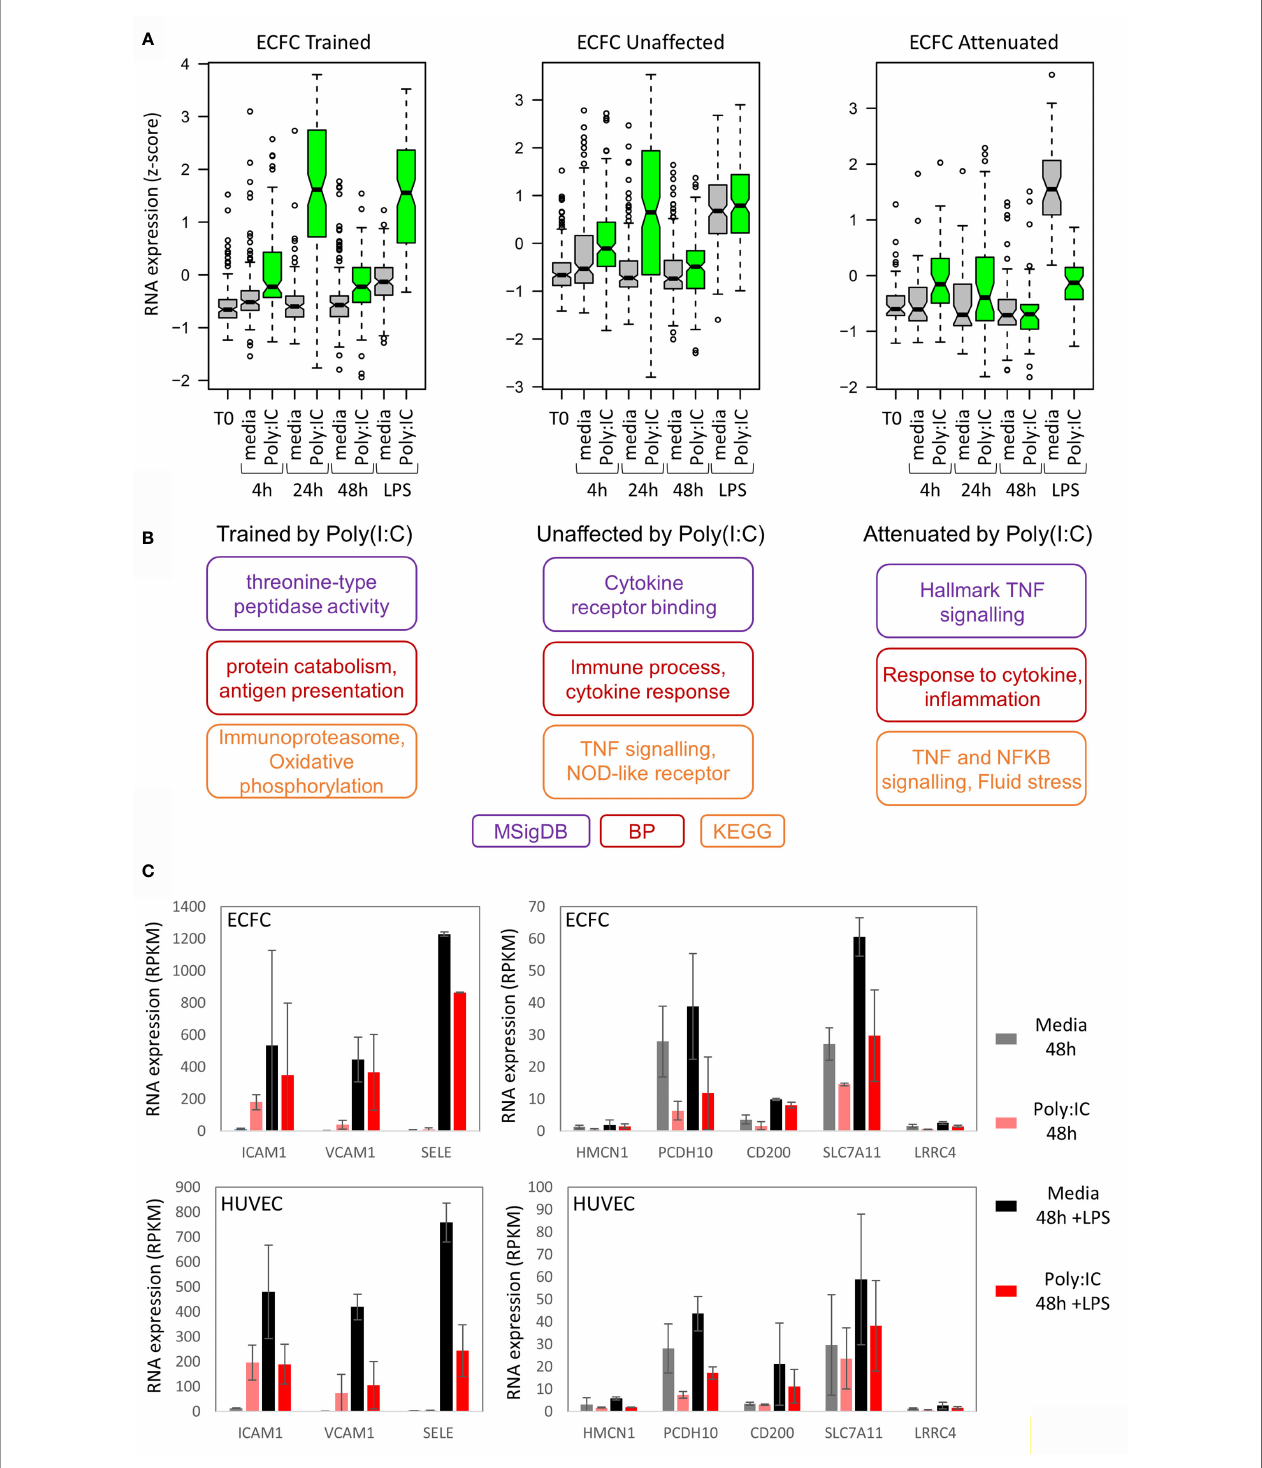
FIGURE 5 | Poly(I:C) tolerizes genes involved in endothelial cell adhesion. (A) Expression of trained, unaffected and tolerized genes over time in ECFCs. This indicates that genes trained for LPS response are more strongly induced by Poly(I:C) initially compared to genes that are tolerized for LPS response. (B) Gene ontology analysis for each group of genes. (C) Expression of cell-adhesion genes that are tolerized for LPS response by